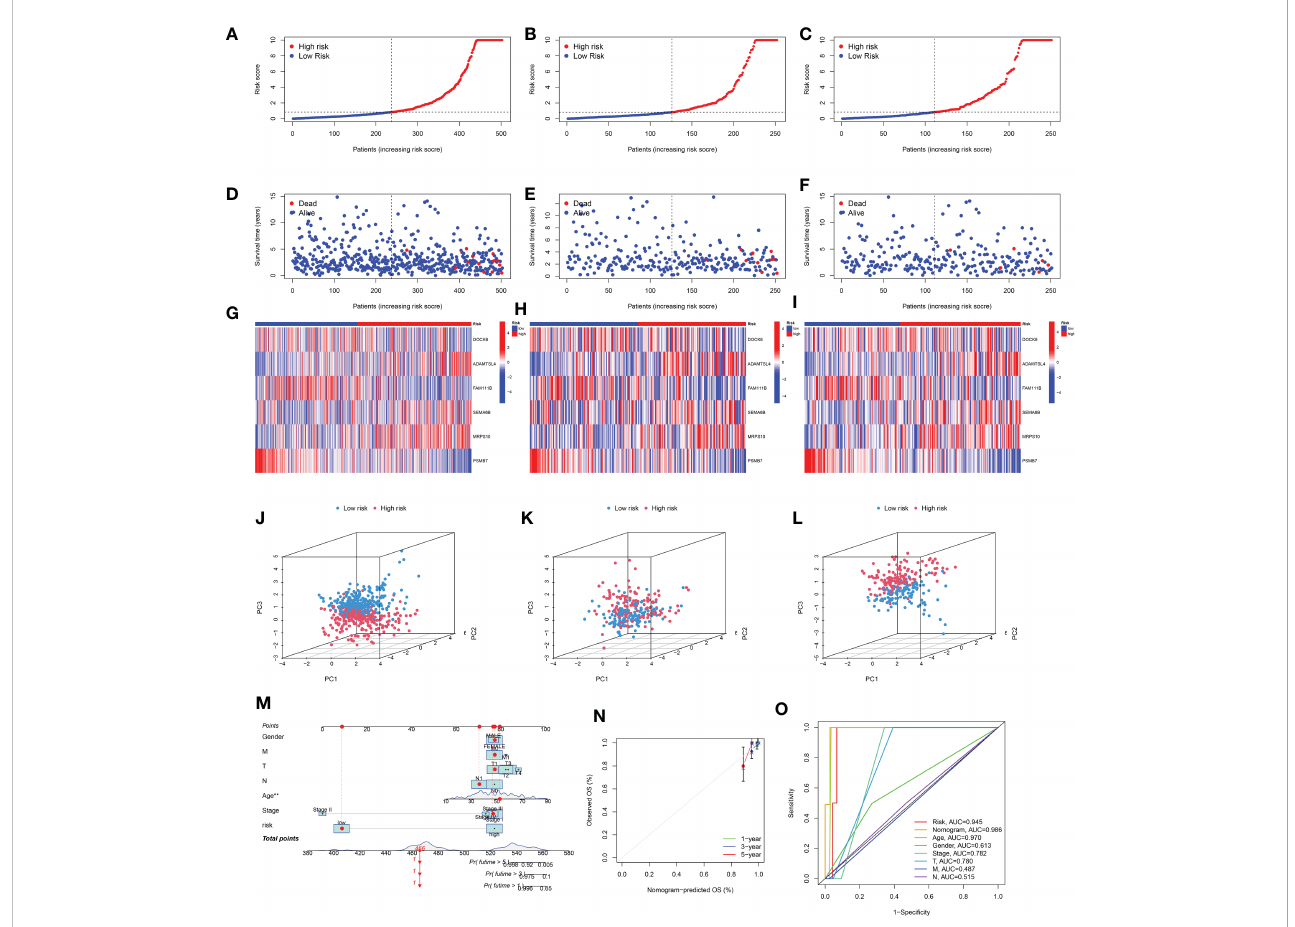
FIGURE 4 Stability of the senescence-related signature and construction of a nomogram. (A – C) Survival curve of the THCA patients across TCGA-all, TCGA- training, and TCGA-test subsets. (D – F) Survival status of the THCA patients across TCGA-all, TCGA-training, and TCGA-test subsets. (G – I) Heatmaps showing the expression of signature genes in THCA patients across the TCGA-all, TCGA-training, and TCGA-test subsets. (J – L) PCA showing the perfect separation of low- and high-risk THCA across the TCGA-all, TCGA-training, and TCGA-test subsets. (M) The nomogram constructed with the senescence-related signature, age, gender, T stage, M stage, N stage, and clinical stage. (N) The calibration curve used to estimate the prediction accuracy of the nomogram. (O) Multi-index ROC curve of the senescence-related signature and other